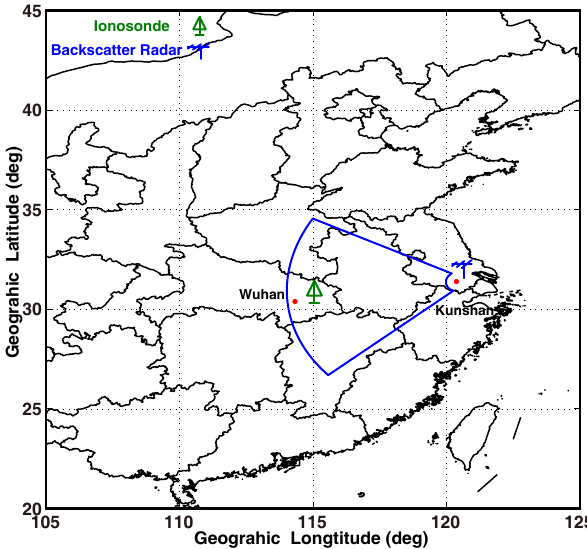
Fig. 6. Map showing the location of the WIOBSS at Kunshan and the location of the vertical ionosonde at Wuhan for the 7 Novem- ber 2012 experiment.